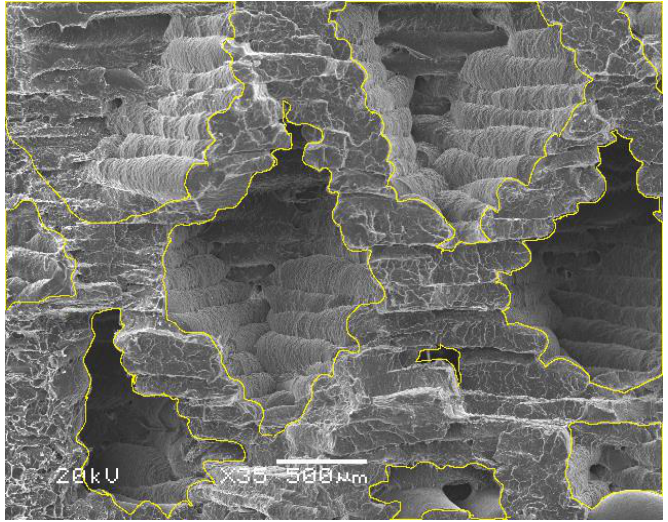
Figure 11. Exemplary SEM image showing how to calculate the real amount of infill in the image using the ImageJ program.